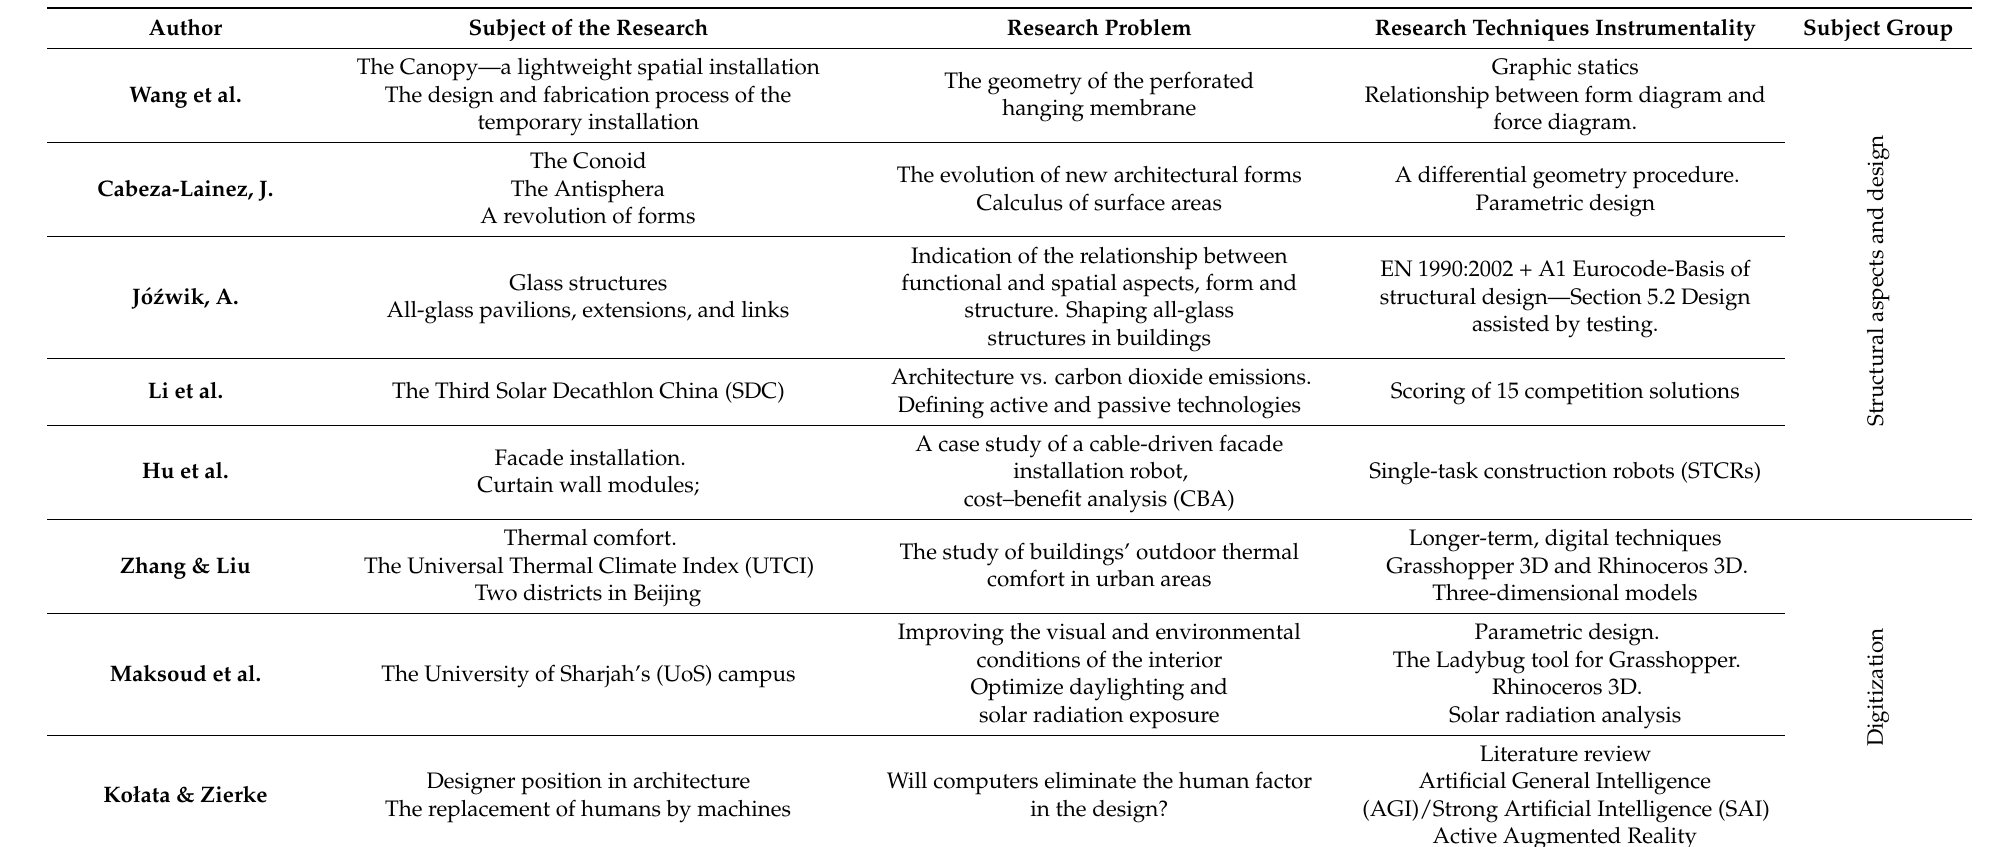
Table 1. The content of the Special Issue “Architecture: Integration of Art and Engineering”. Synthetic